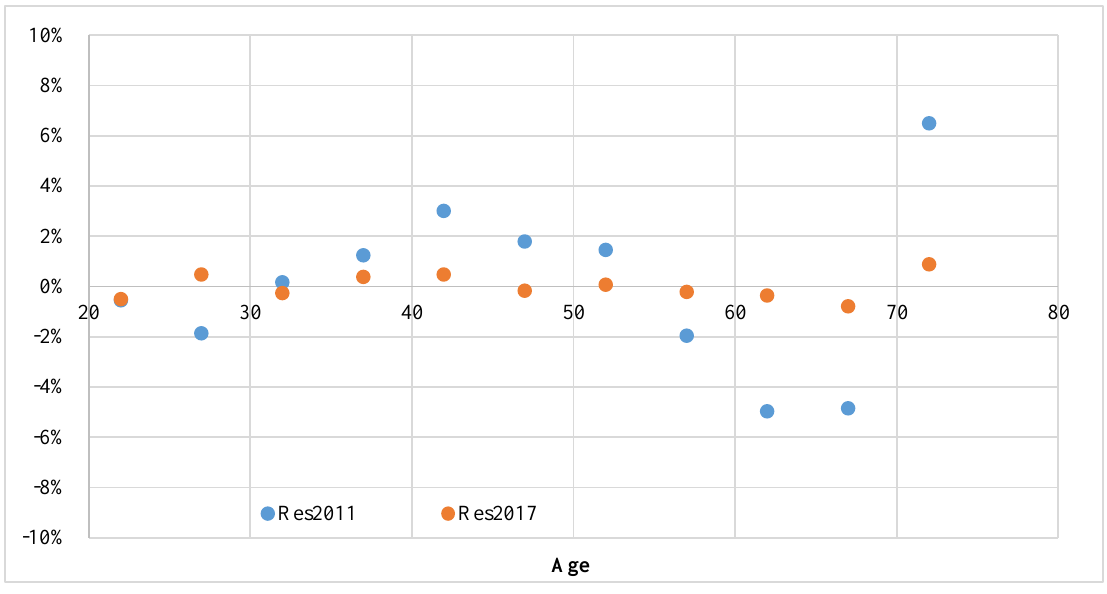
Figure 7. Residuals distributions for models with age.